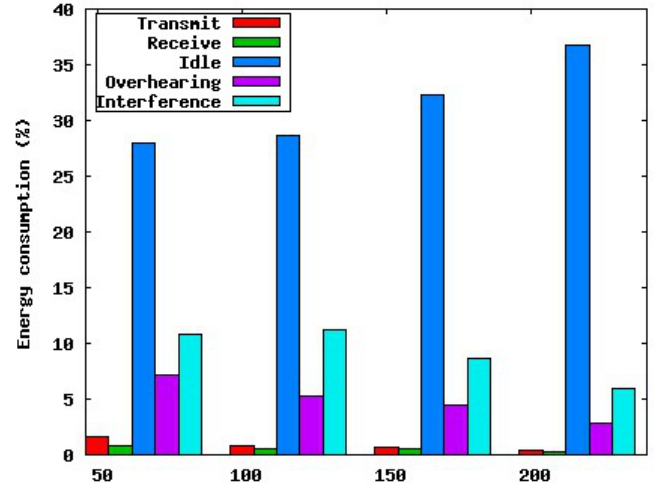
Figure 1. Distribution of node energy consumption without the sleeping